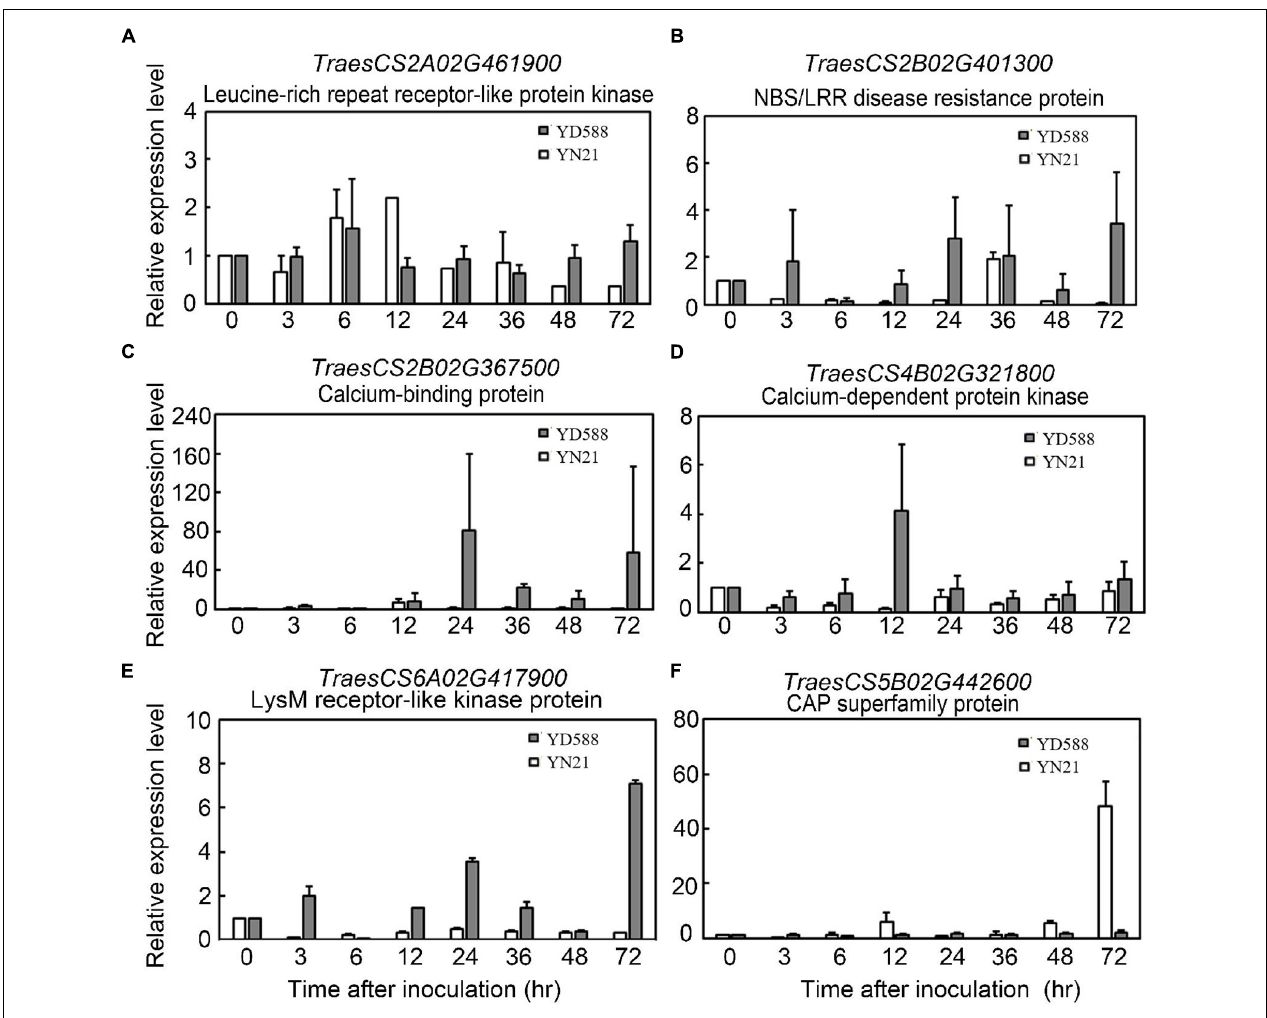
FIGURE 9 | Expression profiles of TraesCS2A02G461900 (A) , TraesCS2B02G401300 (B) , TraesCS2B02G367500 (C) , TraesCS4B02G321800 (D) , TraesCS6A02G417900 (E) , and TraesCS5B02G442600 (F) in each corresponding stage of YD588 and YN21 after Bgt